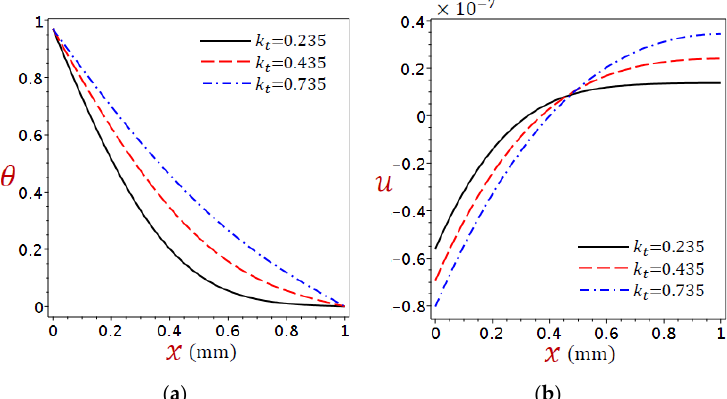
Figure 14. Distributions of ( a ) temperature ( θ ) and ( b ) displacement ( u ) across the skin tissue using numerous values of heat conductivity ( k t ) due to the refined DPL model.